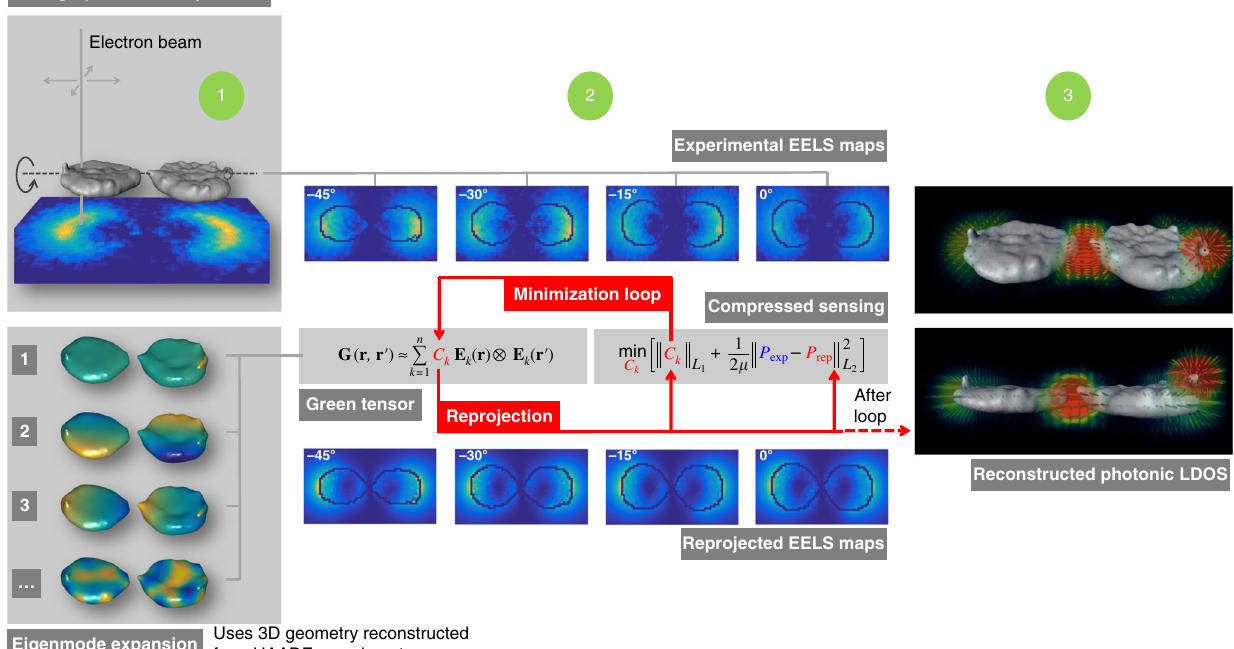
Fig. 1 Tomography scheme for 3D photonic LDOS reconstruction. In a fi rst step we measure high-angle annular dark- fi eld (HAADF) images and electron energy-loss spectroscopy (EELS) maps for different tilt angles. From the HAADF data, we reconstruct the particle geometry and use the geometry for the computation of a generic eigenmode basis E k ( r ). In a second step, the Green tensor G ( r , r ′ ) is decomposed into these eigenmodes and the reprojected EELS maps are computed using some initial guess for the expansion coef fi cients C k . These coef fi cients are determined through solution of an inverse problem such that the difference between the measured and reprojected EELS maps becomes minimized, with a compressed sensing bias that favors decompositions with as few eigenmodes as possible. After minimization, in the third step we use the reconstructed Green tensor to visualize the